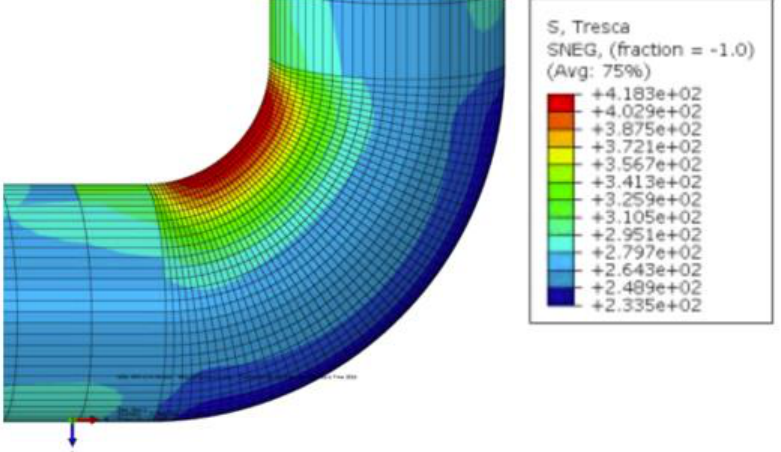
◦ pipe elbow. (Reprinted/adapted with permission from Figure 1. Tresca stresses on a 90° pipe elbow. (Reprinted/adapted with permission from [29]) Figure 1. Tresca stresses on a 90